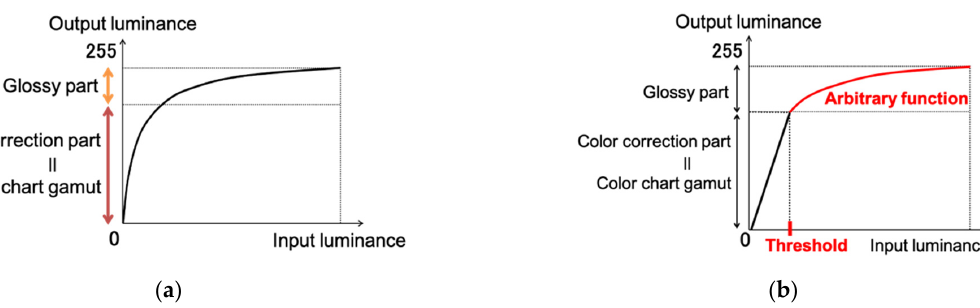
Figure 7. tone mapping function. ( a ) Conventional tone mapping function; ( b ) Proposed Figure 7. Tone mapping function. ( a ) Conventional tone mapping function; ( b ) Proposed tone tone mapping function. mapping function.